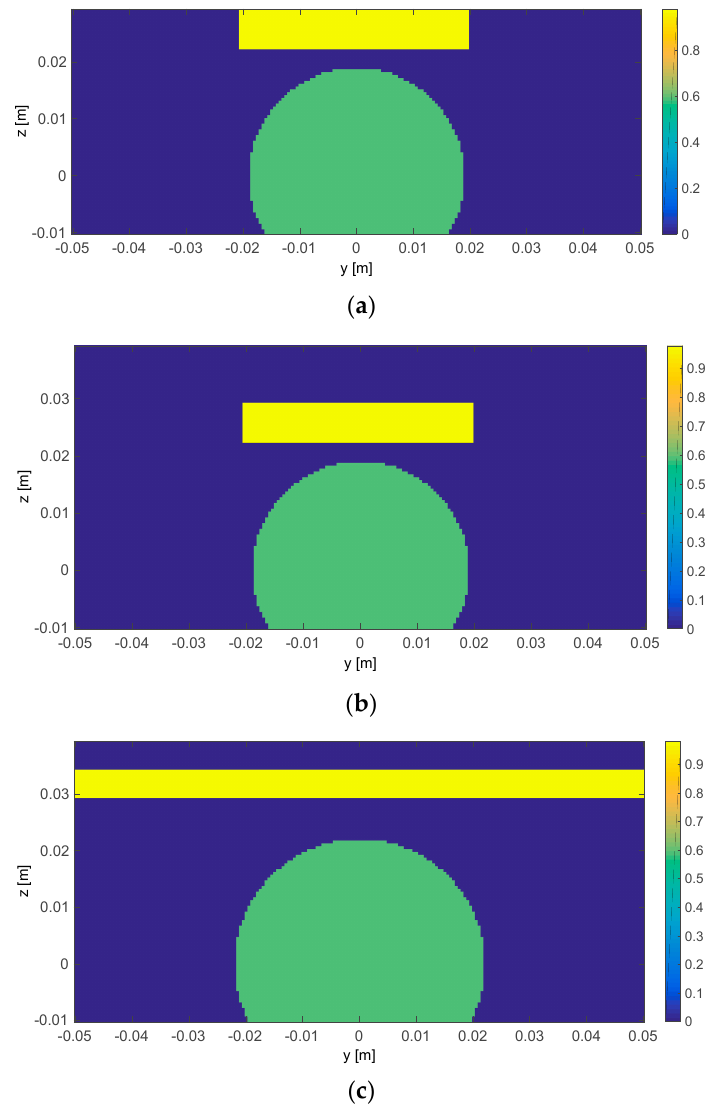
Figure 7. Ideal differential contrast for the analyzed cases. Each figure represents the yz cross-section of the ground truth as deduced from visual inspection. The green areas are ablated tissue, the yellow areas are specimen surface modifications. The MTA applicator is located at (0 m, 0 m). The MWT antenna moves along the top border of each figure. ( a ) Vivaldi experiment with antenna in contact; ( b ) Vivaldi experiment with antenna at 10 mm from the specimen; ( c ) Half-heart experiment with antenna at 10 mm from the specimen. The bar chart of each sub-figure are in the same scale and they denote the absolute value of the differential contrast for the three analyzed cases.